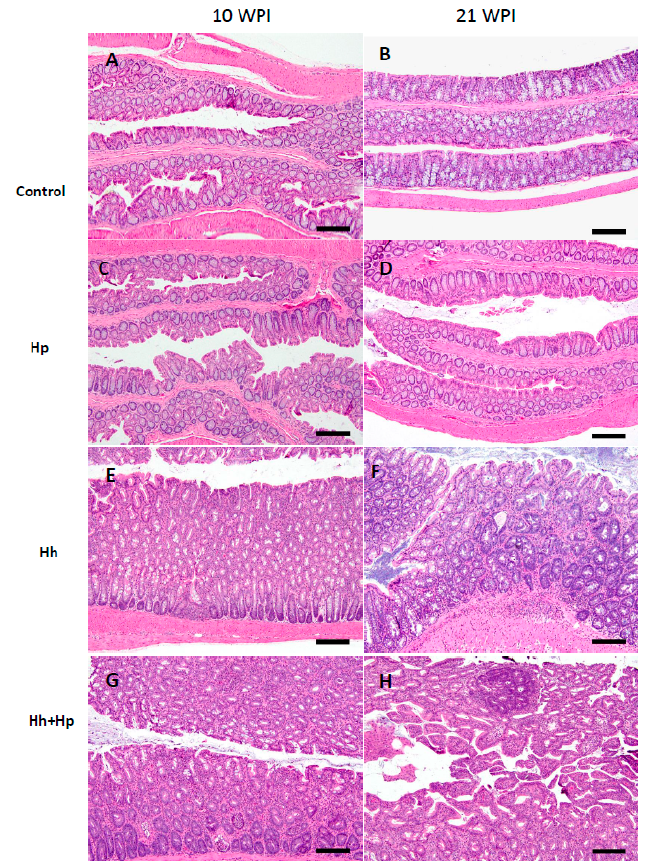
Figure 2. Representative H&E images of colon from male mice of different groups at 10 WPI and 21 WPI. ( A ): uninfected male, 10 WPI. ( B ): uninfected male at 21WPI. ( C ): mono-Hp male at 10 WPI. ( D ): Hp infected male at 21WPI. Panels a-d show none (a,b) to sparse (c&d) lamina propria inflammatory aggregates. ( E ): Hh infected male at 10 WPI showing moderate diffuse mucosal inflammation with hyperplastic and mildly ectatic glands and mild dysplasia. ( F ): mono-Hh male at 21 WPI showing moderate to severe mucosal and submucosal inflammation with ectatic and hyperplastic glands and moderate dysplasia. ( G ): Hh+Hp male at 10 WPI showing moderate to severe mucosal inflammation with crypt abscessation, ectatic glands, surface epithelial tethering, and hyperplastic and dysplastic glands. ( H ): Hh+Hp male at 21 WPI showing diffuse mucosal inflammation and villo-papillary hyperplastic and adenomatous epithelial proliferation. BAR, all images: 150 µM.